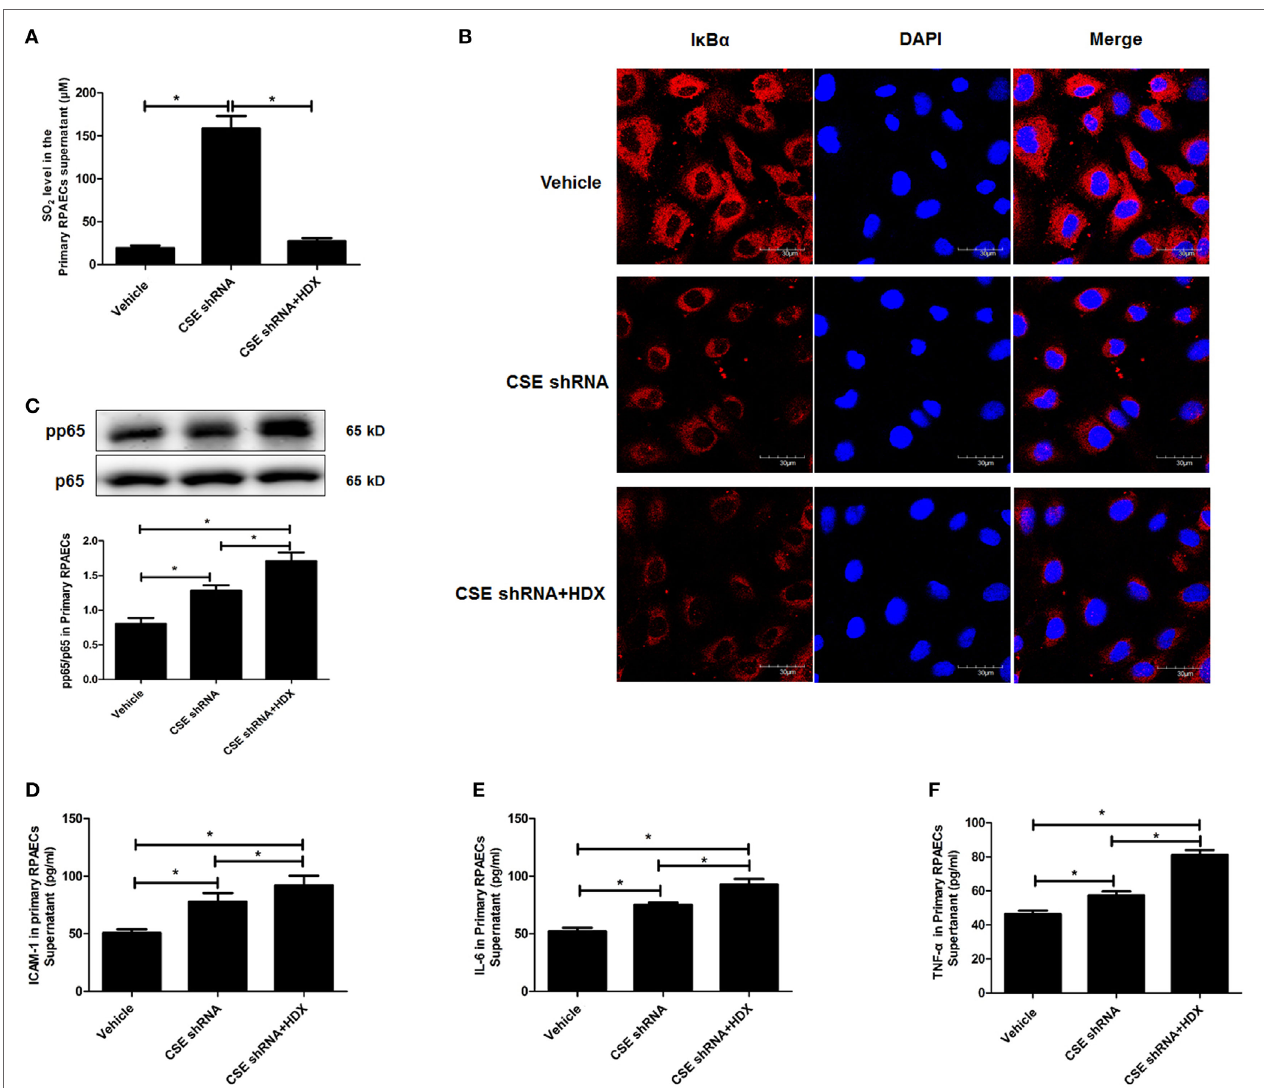
FigUre 7 | Aspartate aminotransferase inhibitor l -aspartate- β -hydroxamate (HDX) aggravated the inflammation caused by cystathionine- γ -lyase (CSE) knockdown in primary rat pulmonary artery endothelial cells (RPAECs). (a) The SO 2 level in the supernatant of primary RPAECs detected by HPLC analysis. (B) The expression of I κ B α in the primary RPAECs detected by western blot. (c) The phosphorylation of NF- κ B p65 in the primary RPAECs detected by western blot. The level of ICAM-1 (D) , IL-6 (e) , and TNF- α (F) in the supernatant of the primary RPAECs detected by enzyme-linked immunosorbent assay. * P < 0.05. Data are expressed as means ± SEM, and all experiments were performed independently for at least three